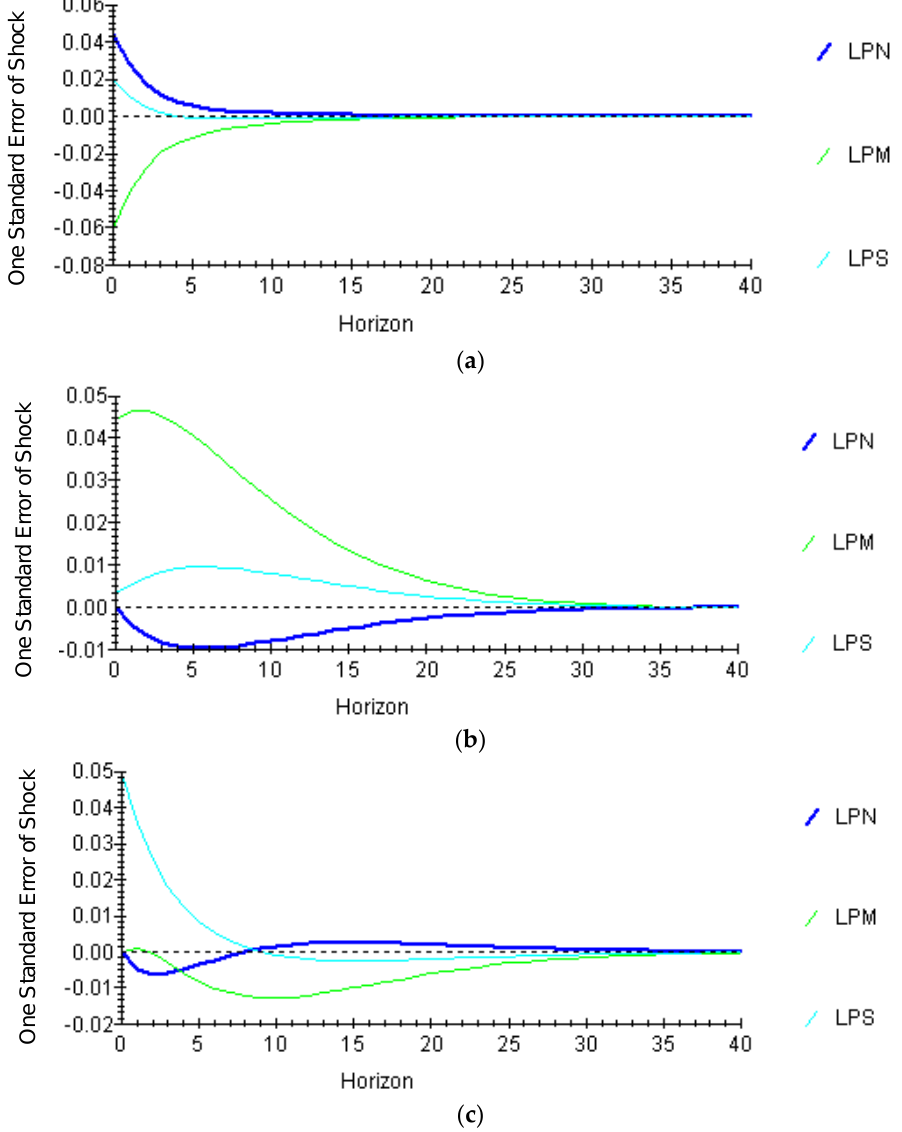
Figure 2. ( a ) Orthogonalized Impulse Responses to one Standard Error Shock in the LPN Equations; ( b ) Orthogonalized Impulse Responses to one Standard Error Shock in the LPM Equations; ( c ) Orthogonalized Impulse Responses to one Standard Error Shock in the LPS Equations.